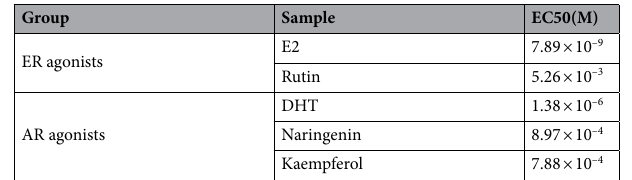
Table 3. ER and AR agonistic effects (EC50 values). ER estrogenic receptor, AR androgenic receptor, E2 17β-estradiol, DHT 5α-dihydrotestosterone.